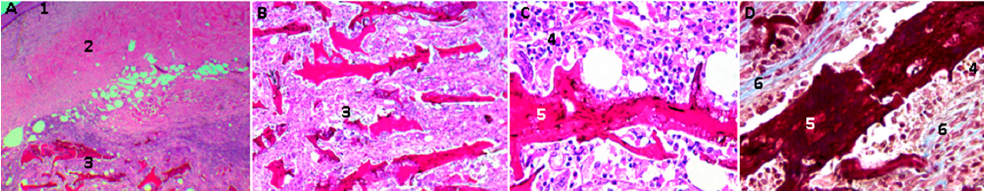
Figure 10. Scaffolds of chitosan/graphene oxide (CS/GO) 0.5% implanted in rat skin; in the images, ( A , B ) scaffolds are appraised to 4× and 10×, respectively, using the Hematoxylin-Eosin Technique. Images ( C , D ), at 40×, are scaffolds in the process of degradation and are surrounded by a mixed inflammatory infiltrate. Image ( D ) is made using Masson’s trichromacy technique; in this image we can see a fibrous tissue capsule surrounding the CS/GO scaffolds. 1: epidermis, 2: Dermis. 3: subcutaneous cellular tissue (implantation zone), 4. Mixed inflammatory infiltrates, 5. Scaffolding CS/GO 0.5%, 6: Fibrous capsule. Technique. Image ( A ) is at 4× magnification, Image B at 10×. Image ( C ) at 40×.